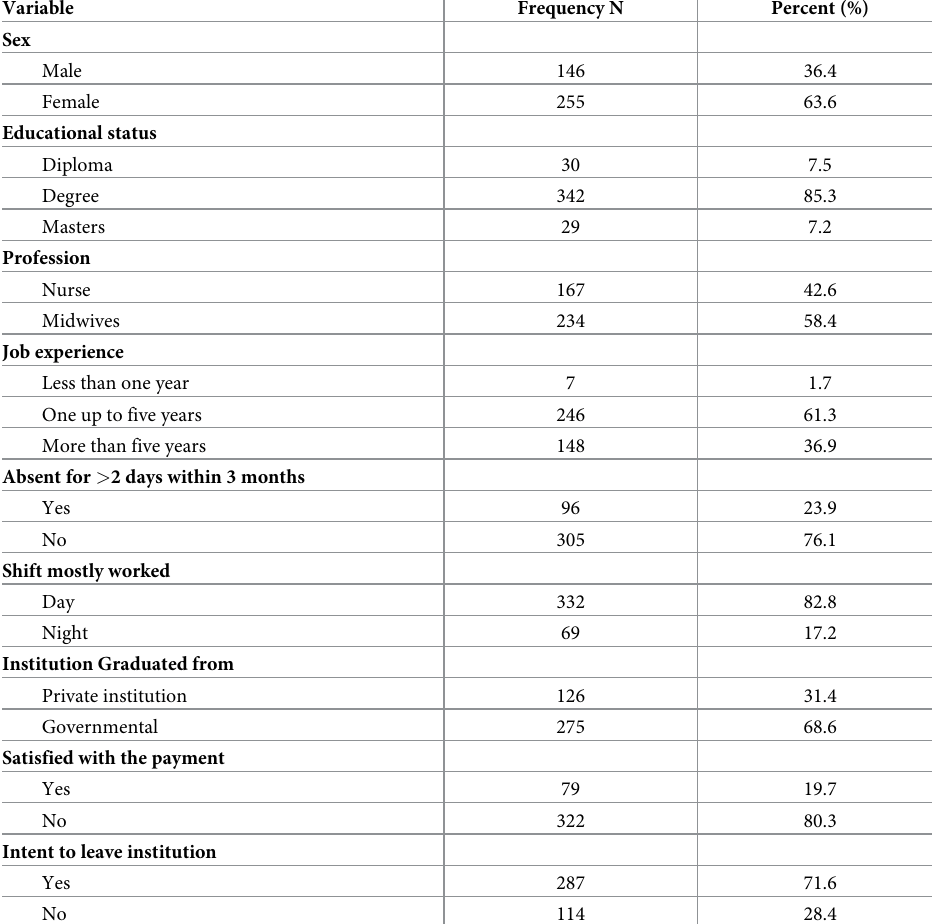
Table 1. Socio demographic and personal characteristics of participants (N =